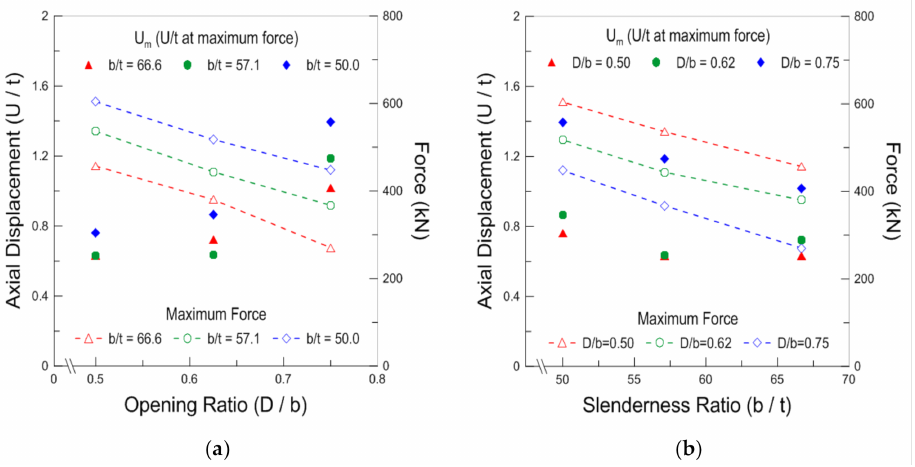
Figure 8. Axial displacement/force dependent on ( a ) the opening ratio (D/b) and ( b ) slenderness ratio (b/t) at ultimate strength of perforated